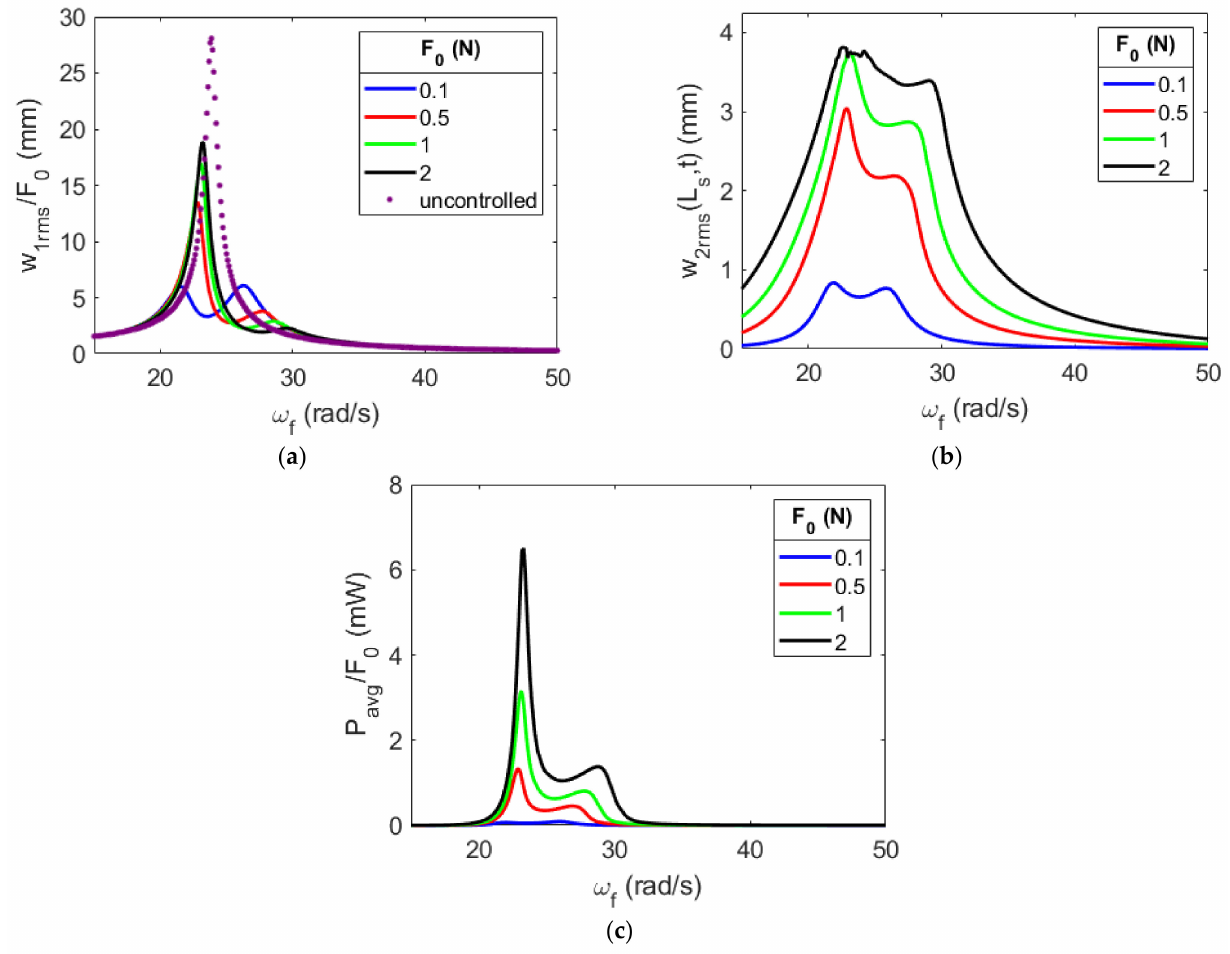
Figure 32. Forcing amplitude effects with a gap of 5 mm on the ( a ) primary structure’s normalized displacement, ( b ) the absorber’s displacement and ( c ) the normalized power